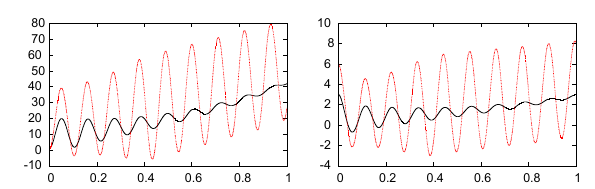
Fig. 6. Aeroelastic response in terms h ( t ) (on the left) and α ( t ) (on the right) for U = 40 m / s in dependence on the value of the initial displacement of α